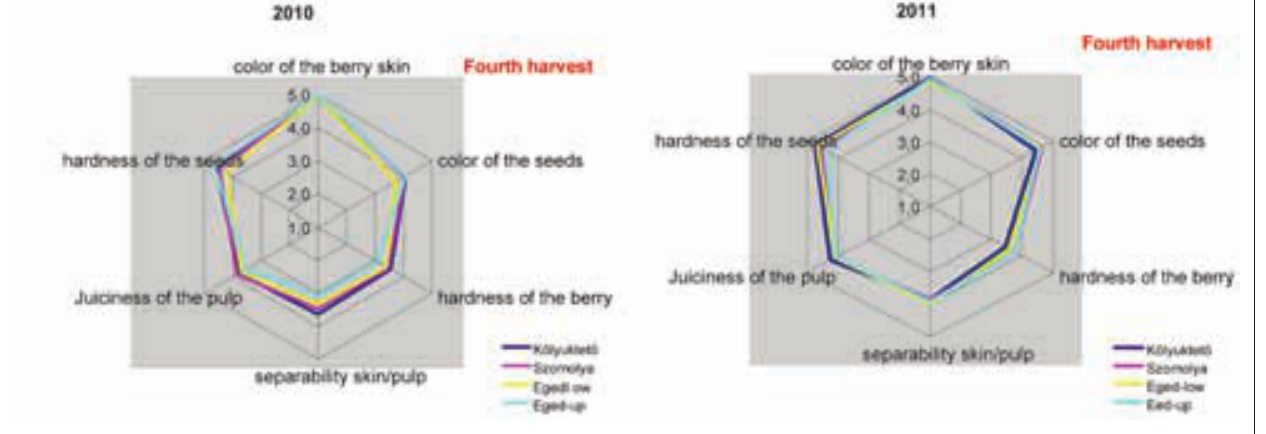
Figure 3 d: Main physical parameters of the berry (2010-2011-Fourth harvest